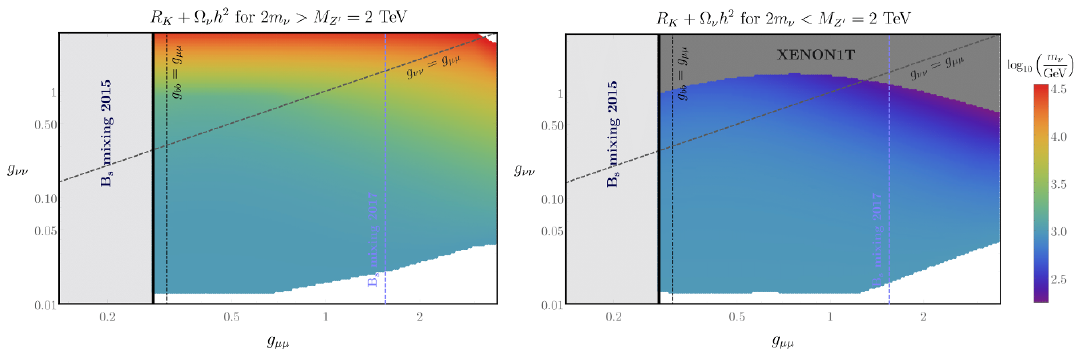
Figure 10 . Summary of the constraints for M Z 0 = 2 TeV. See text in section 5 for details.